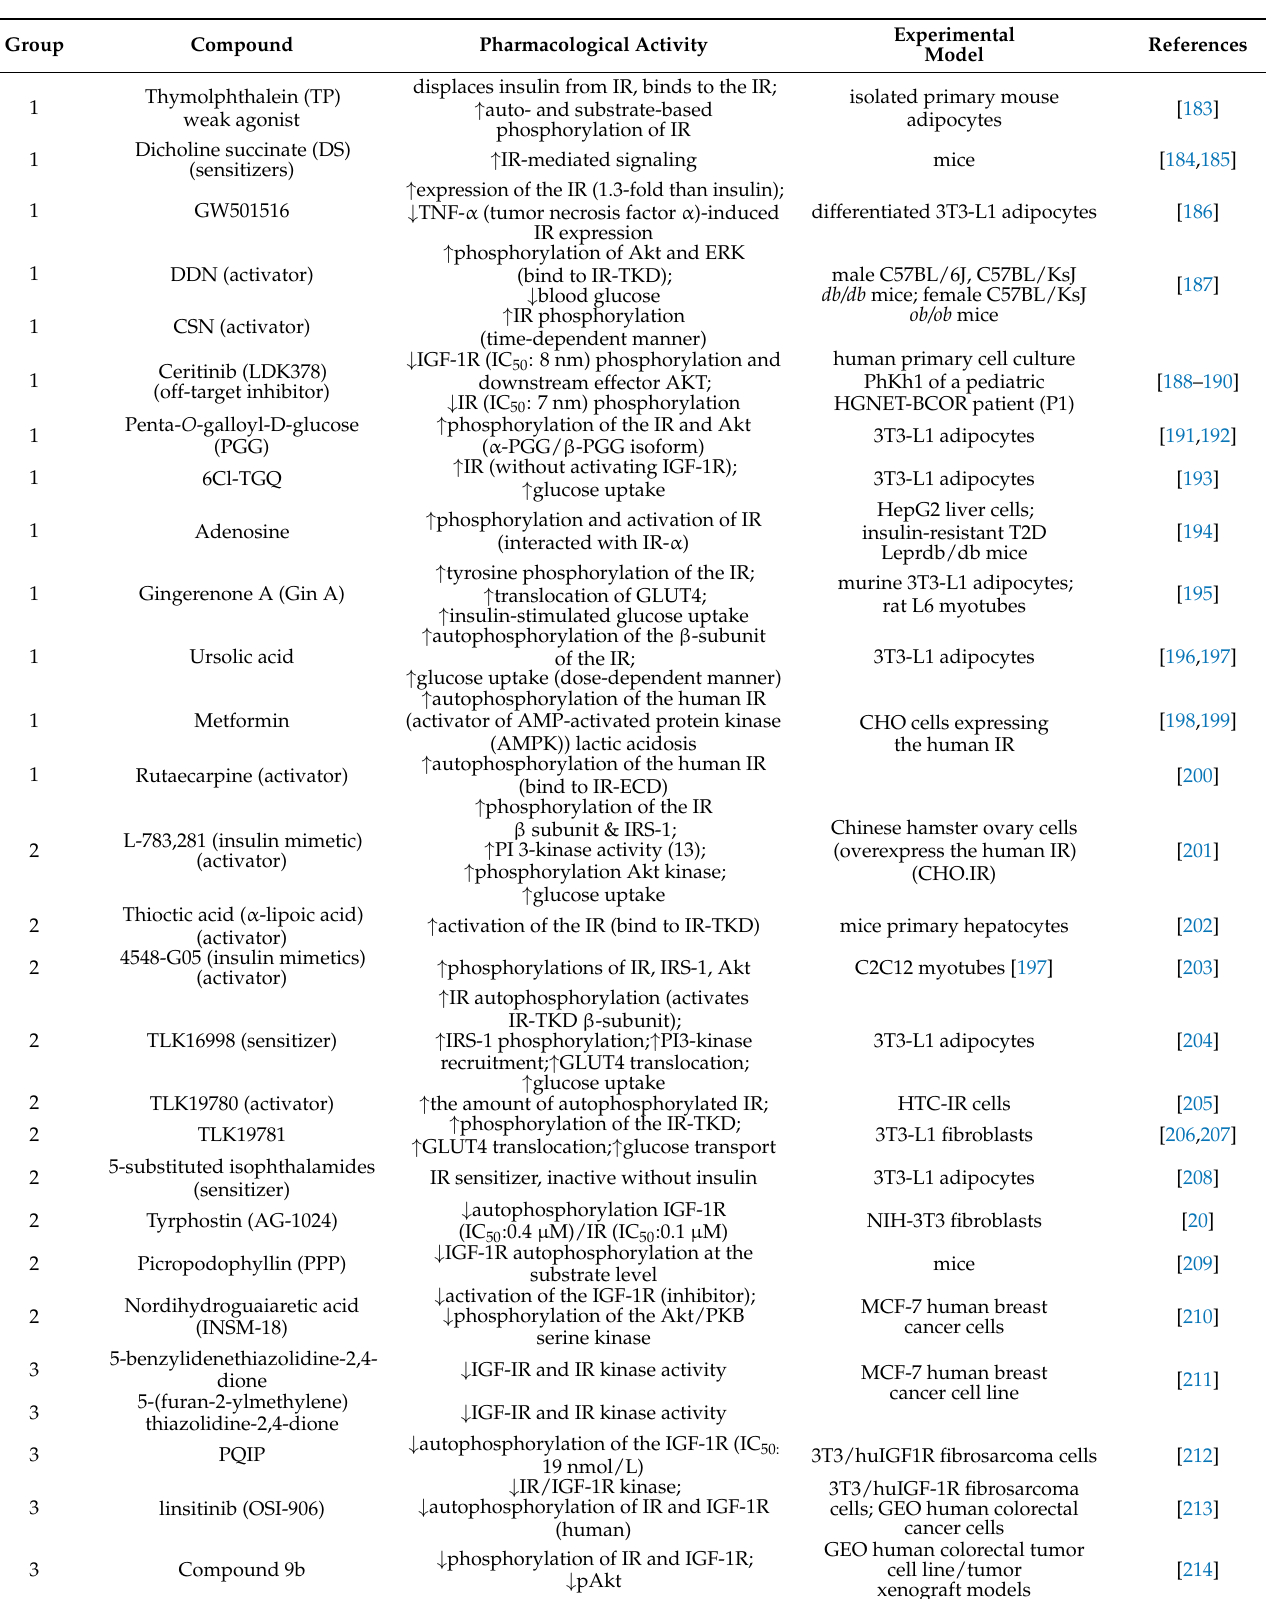
Table 3. Small-molecule positive modulators of the